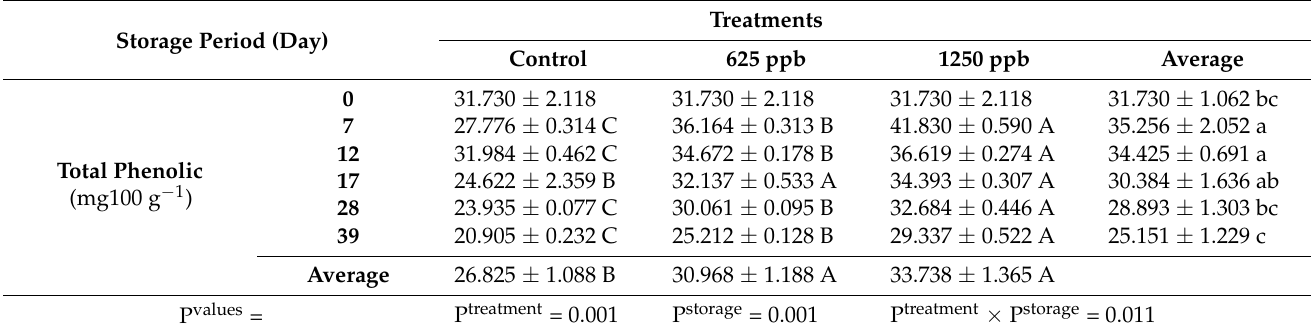
Table 5. The total phenolic content and antioxidant capacity during storage of ‘Seyit F1’ cocktail tomato ( Solanum lycopersicum L.). Data are presented as means ±